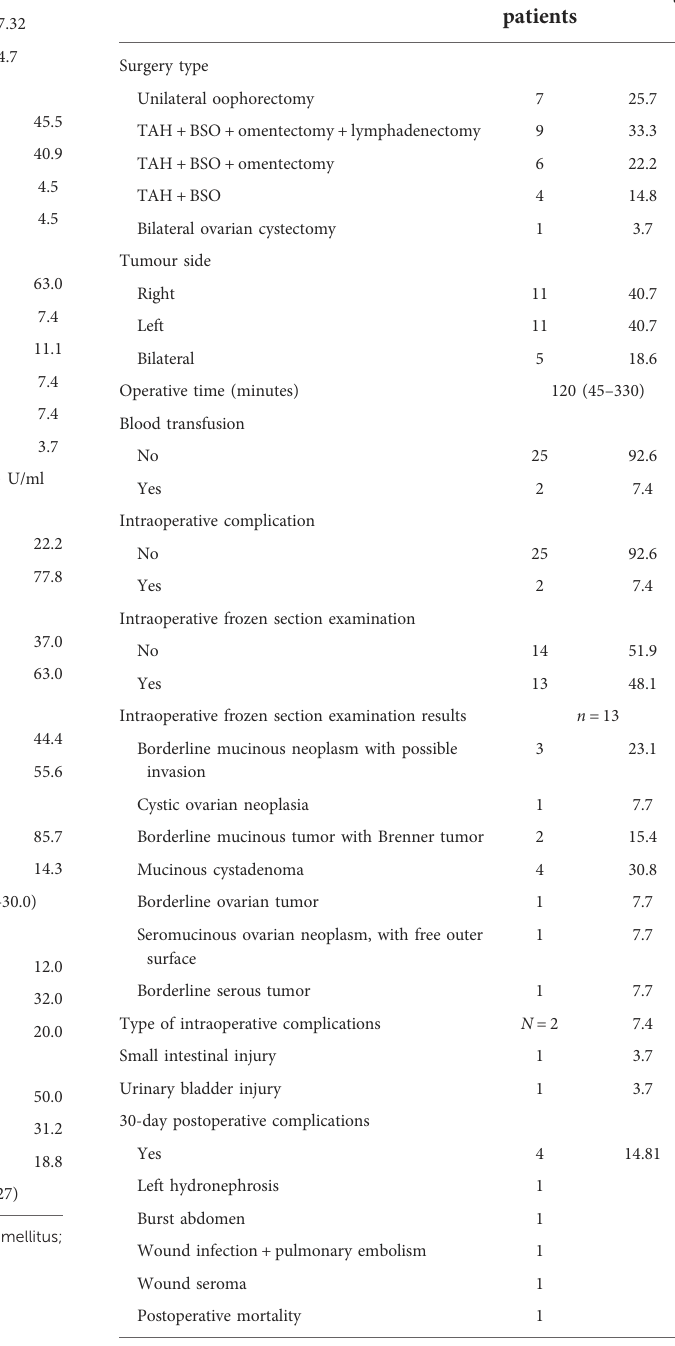
TABLE 2 Operative and postoperative parameters of the studied patients.